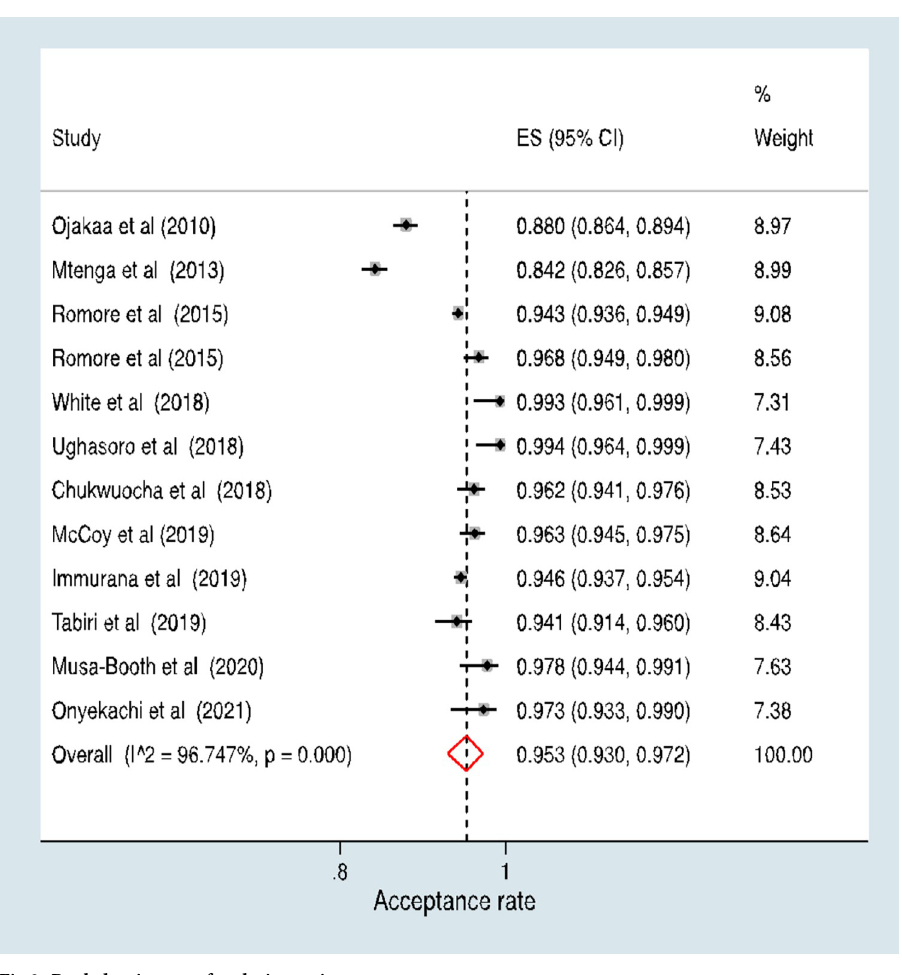
Fig 3. Pooled estimates of malaria vaccine acceptance